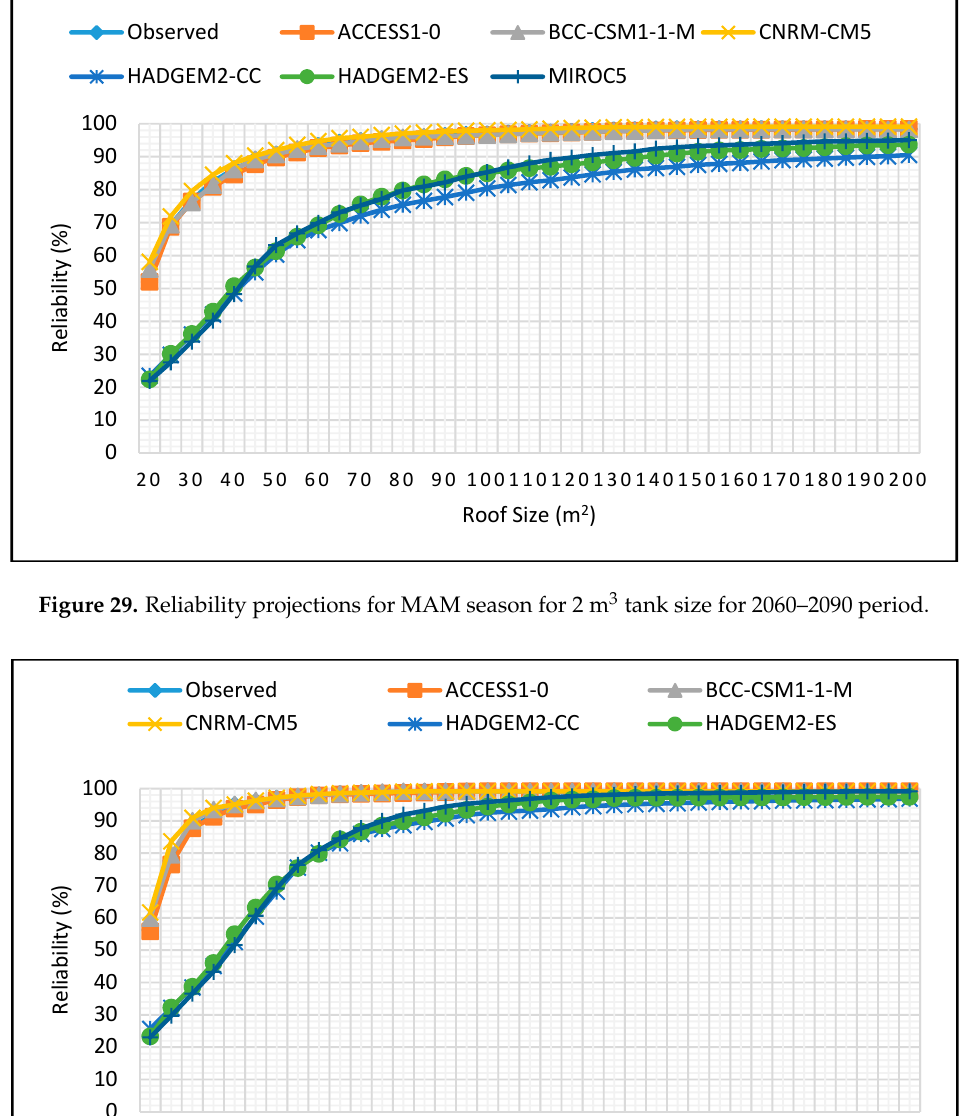
Figure 28. Reliability projections for MAM season for 0.5 m 3 tank size for 2060–2090 period.